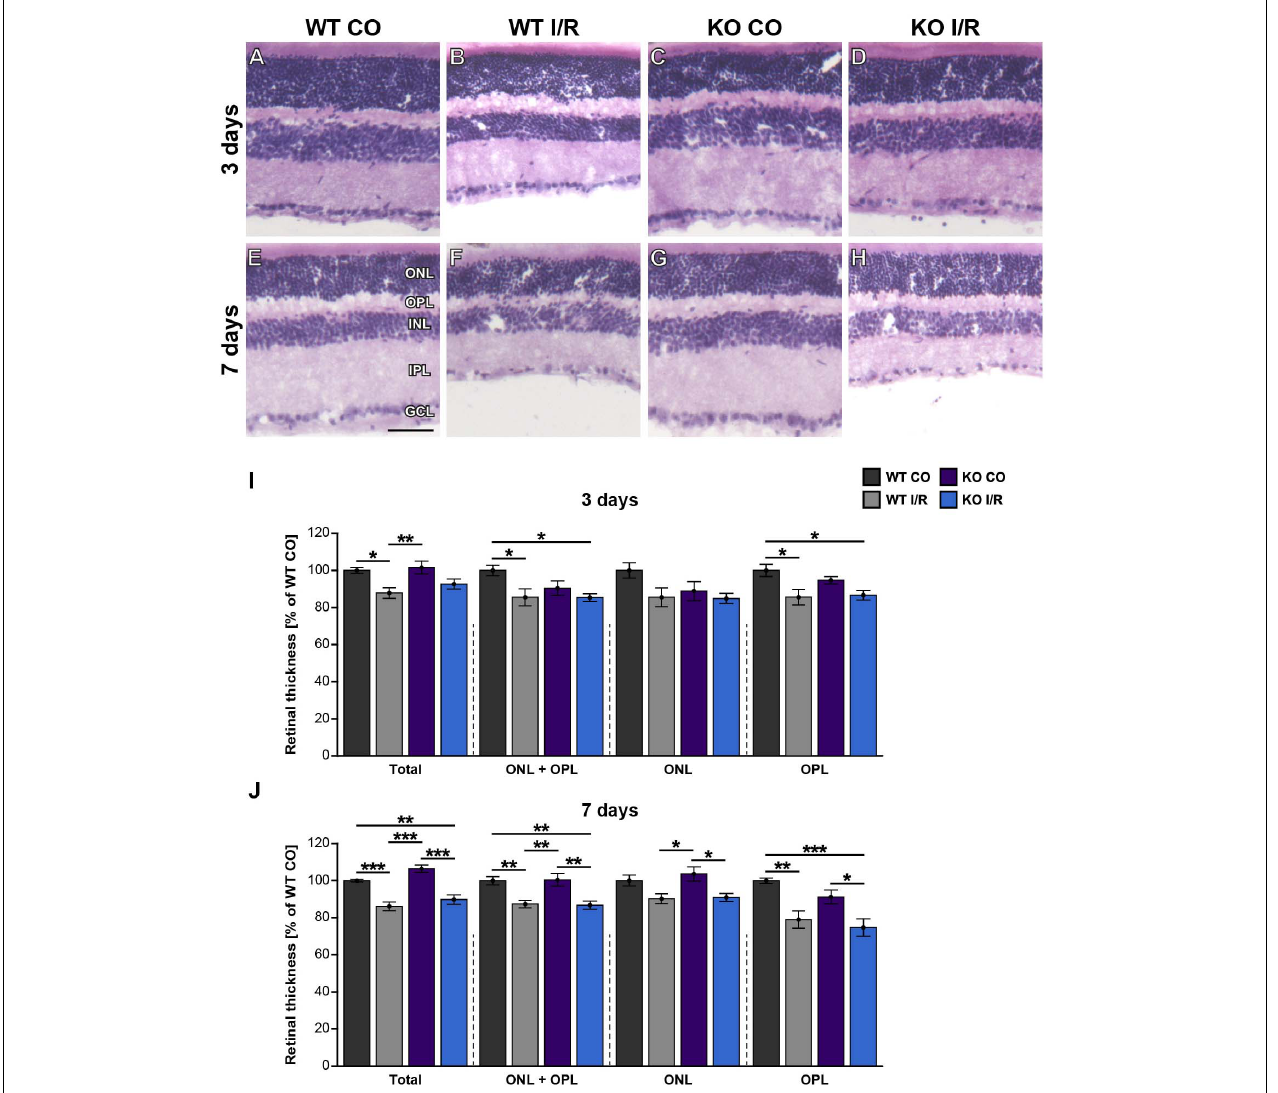
FIGURE 3 | Maintenance of early retinal integrity in Tnc KO mice. (A–H) Cross-sections of control and ischemic WT and KO retinae were stained with H&E at 3 and 7 days post-I/R. (I) At 3 days, a significant reduction of the total, ONL and OPL as well as OPL retinal thickness was noted in the WT I/R group compared to the WT CO group. However, overall outer retinal thickness was comparable in the KO I/R and KO CO group, suggesting an improved structural retinal integrity in the KO early after ischemia. (J) At 7 days, a comparable, progressive decline in the outer retinal thickness was observed in both ischemic groups. Groups were analyzed using two-way ANOVA followed by Tukey’s post hoc test. Data are displayed as mean ± SEM in panels (I,J) . The WT CO group was set to 100%. * p < 0.05, ** p < 0.01, *** p < 0.01. n = 5/group. Scale bar = 50 µ m. ONL: outer nuclear layer, OPL: outer plexiform layer, INL: inner nuclear layer, IPL: inner plexiform layer, GCL: ganglion cell